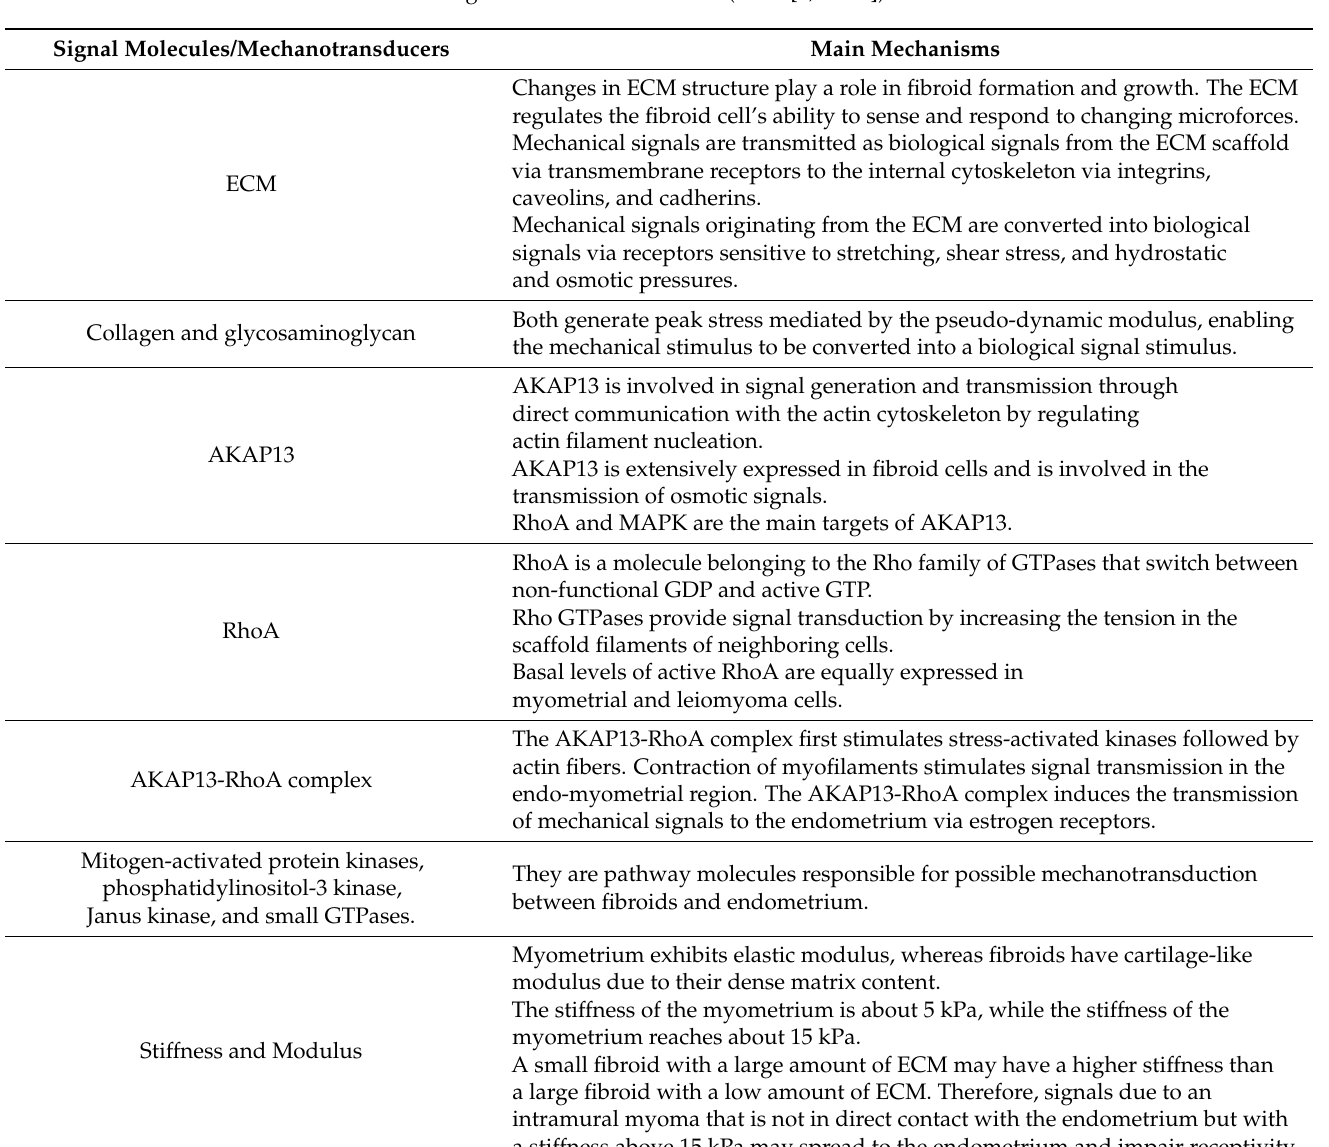
Table 1. Signaling molecules and main mechanisms involved in the transmission of fibroid-derived mechanical signals to the endometrium (Refs.